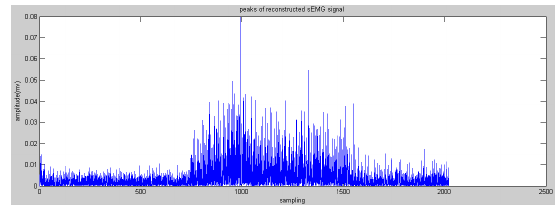
Figure 10. Peaks of the reconstructed sEMG in node 4.1.